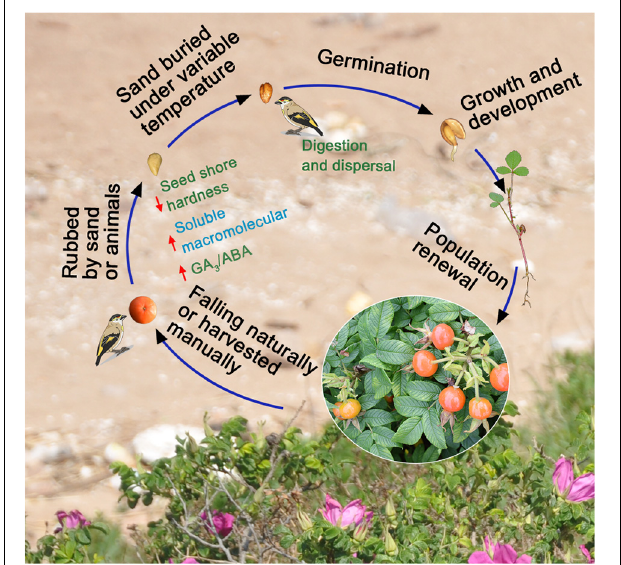
FIGURE 6 | In nature, the possible process of seed harvest, stratification, germination, dispersal, and population update after the fruits of Rosa rugosa